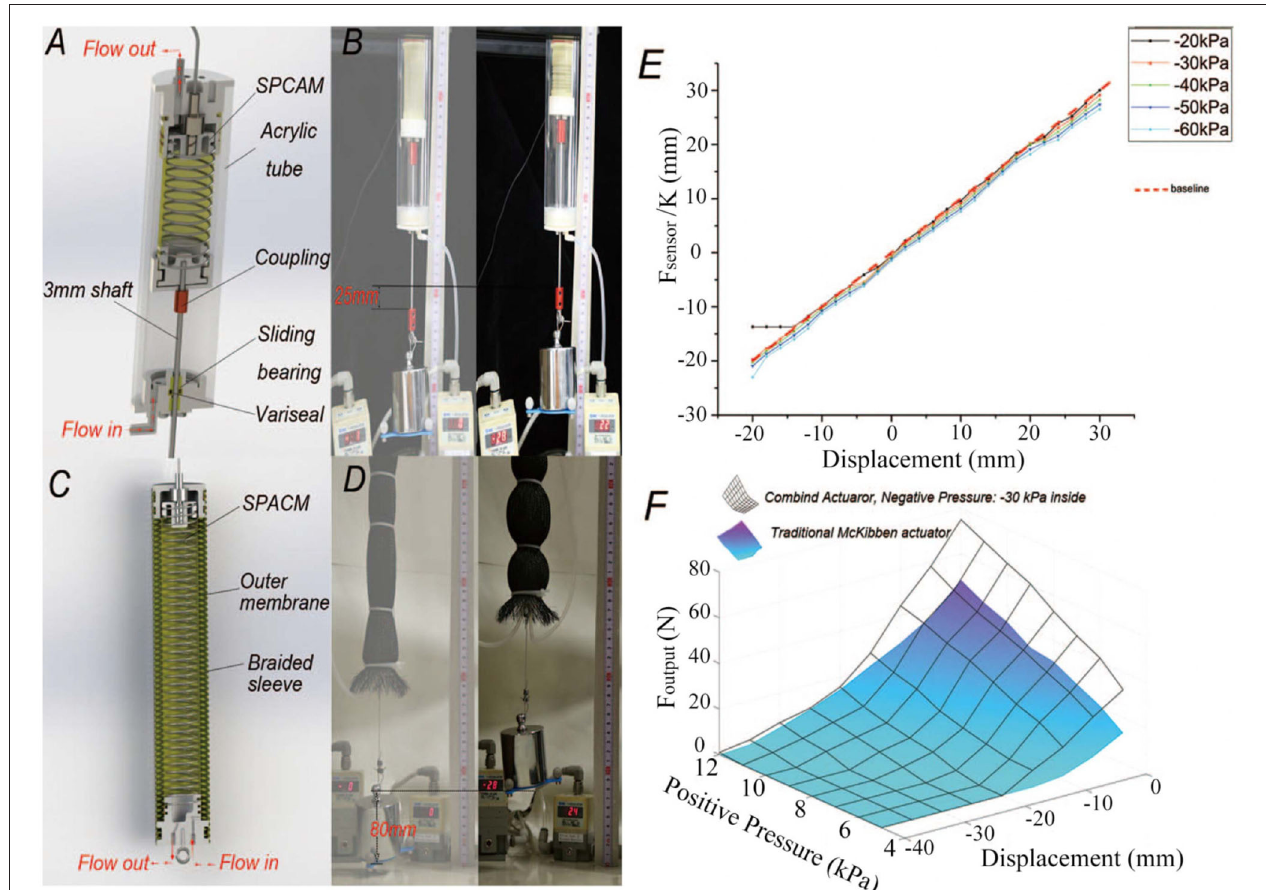
FIGURE 8 | The structures and performance of two different types of combined actuator. (A) The schematic of negative–positive pressure combined air cylinder. (B) Demonstration of the combined air cylinder actuator. The actuator can still get satisfactory output force and displacement even both positive and negative pressure difference is under 30 kPa. (C) The structural drawing of the second type of actuator which combined the SPCAM with McKibben artificial muscle. (D) The actual performance of the second combined actuator. It is able to lift the 1 kg weight for about 80 mm. (E) The accuracy of air cylinder combined actuator. The RMSE of the combined actuator is about 1.0 mm and the maximum error is 3.5 mm, much smaller than that of original actuator b alone. (F) The relation among displacement, actuation pressure, and output force of McKibben-combined actuator and traditional one. Under low-pressure actuation, the output force of the combined actuator (represented by the black surface, -30 kPa vacuum pressure inside) is larger than that of the traditional artificial muscle (colored surface) and maximum contracting displacement also